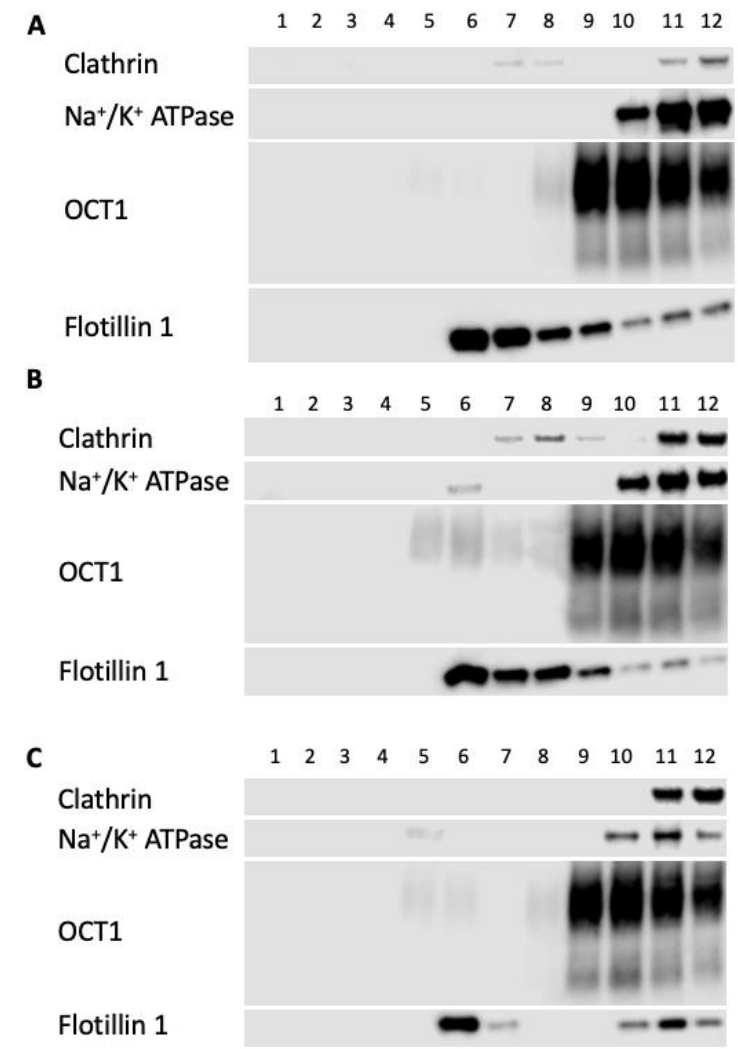
Figure 10. Distribution of marker proteins in lipid rafts isolated from OCT1-expressing HEK293 cells. HEK293 cells expressing OCT1 were incubated with ( A ) Opti-MEM (control), ( B ) 0.4 mM cholesterol, or ( C ) 20 mM MCD before being homogenized, centrifugated, and fractionated as outlined in the Materials and Methods section. Aliquots of the 1 mL gradient fractions were analyzed using western blotting. Positive lipid raft markers are caveolin and flotillin-1; negative markers are clathrin and Na + /K + ATPase.